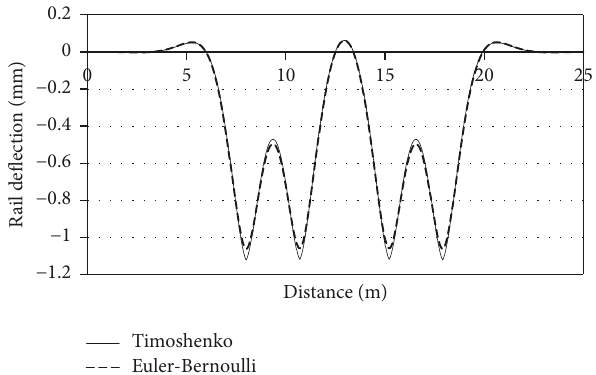
Figure 7: Rail deflection line for V = 300 km/h and for two types of models: the Euler-Bernoulli and the Timoshenko beams.